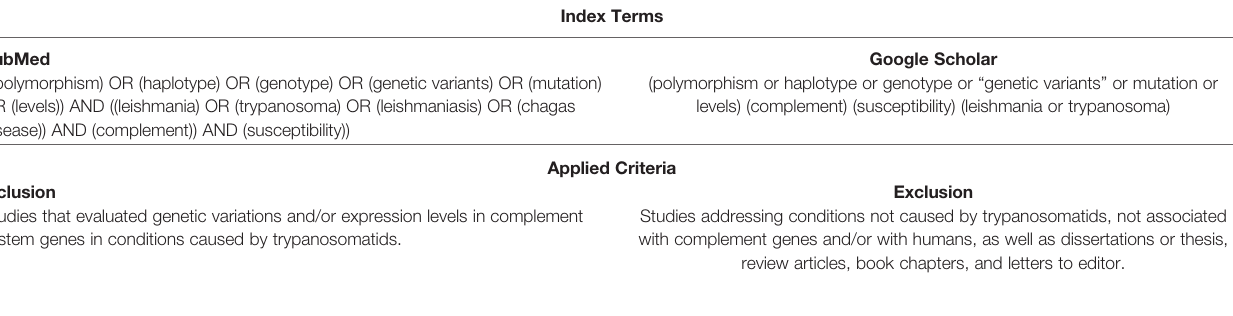
role against severe cardiomyopathic disease.